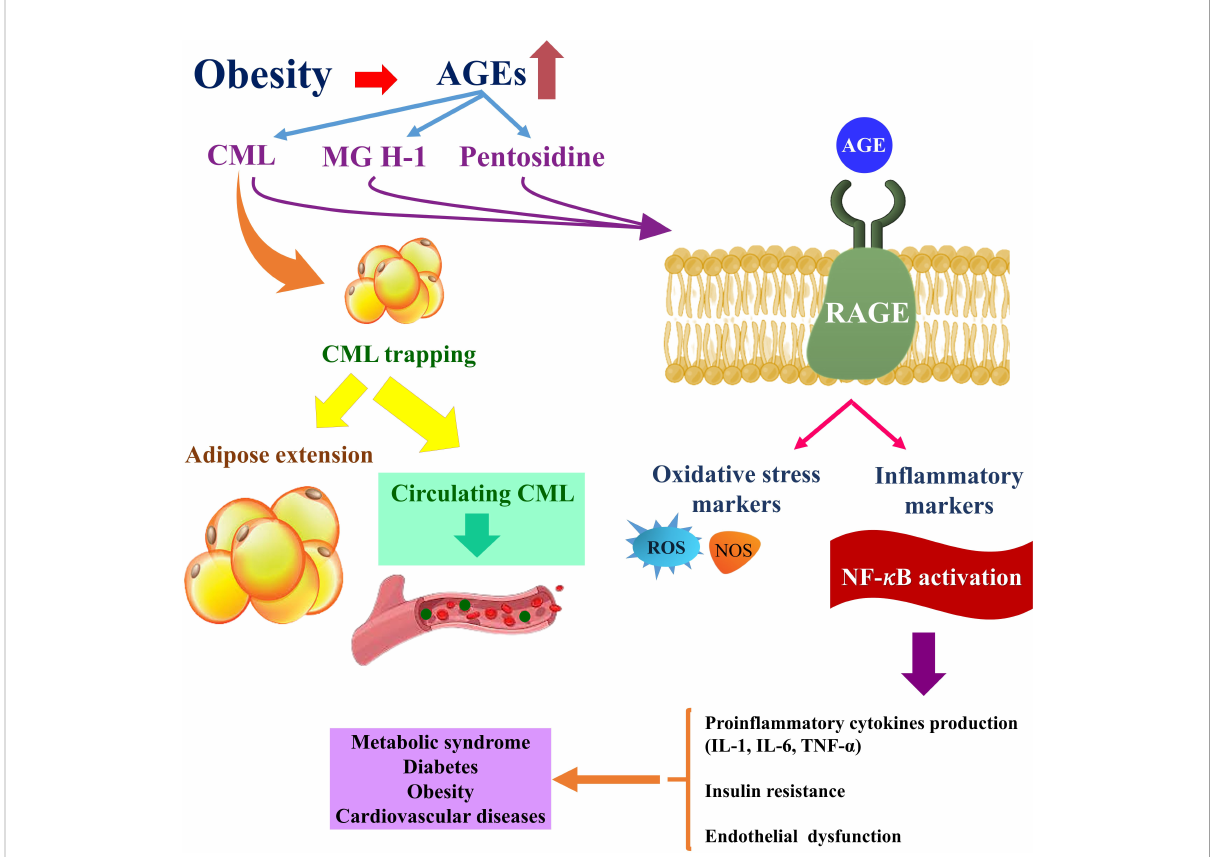
FIGURE 5 Obesity-related complications areexacerbatedby the accumulation ofAGEs in adipose tissue. Obesity-related CML accumulationand CML-RAGE- mediated activation ofintracellular signaling pathways inadipocytesmay promote in fl ammatorysignaling in adipose tissue.The dysregulation ofpro- in fl ammatory and anti-in fl ammatorycytokinesthat results may then contribute tothe development ofobesity-related complications such as metabolic syndrome, diabetes, and cardiovascular diseases (42).On the otherhand, trapping CML in adipose tissue reduces serum levels of CML inthe bloodstream andexpandsadipose tissue. Because of the negative relationship offat mass with serum CML concentrations, serum CML levels may be lower among the obese compared withthose who are lean despite a higher intake ofAGE-richfoods (20). AGE, advanced glycationend product; CML, carboxymethyl-lysine; MG H1, methylglyoxal-derived hydroimidazolone; RAGE,receptor for advanced glycation end products; NF- k B, nuclear factor k B; ROS, reactive oxygen species; NOS, nitric oxide; IL, interleukin; TNF- a , tumor necrosis